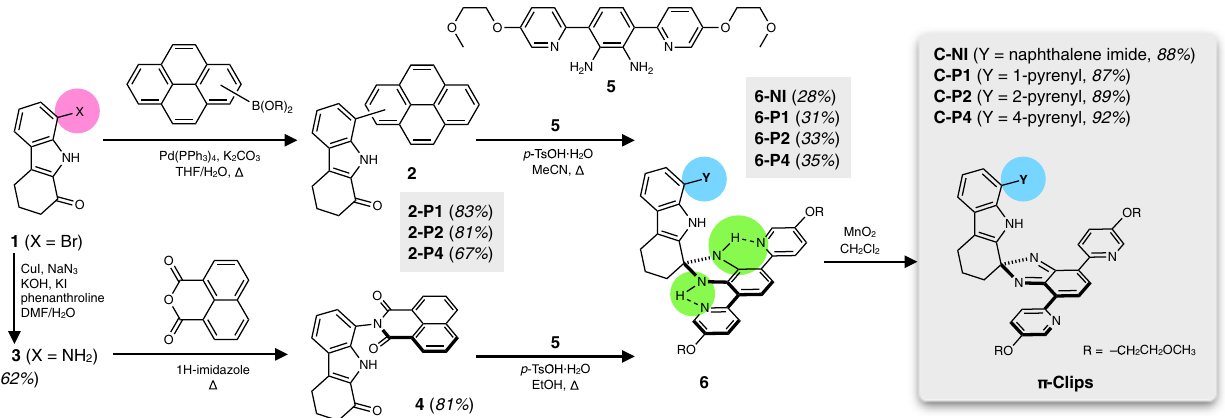
Fig. 2 Synthesis of π -clips. The modular construction of C-NI and regioisomeric C-P n ( n = 1, 2, and 4) series π -clip molecules. THF tetrahydrofuran, DMF N,N -dimethylformamide, p -TsOH para -toluenesulfonic acid, Me methyl, Et ethyl.